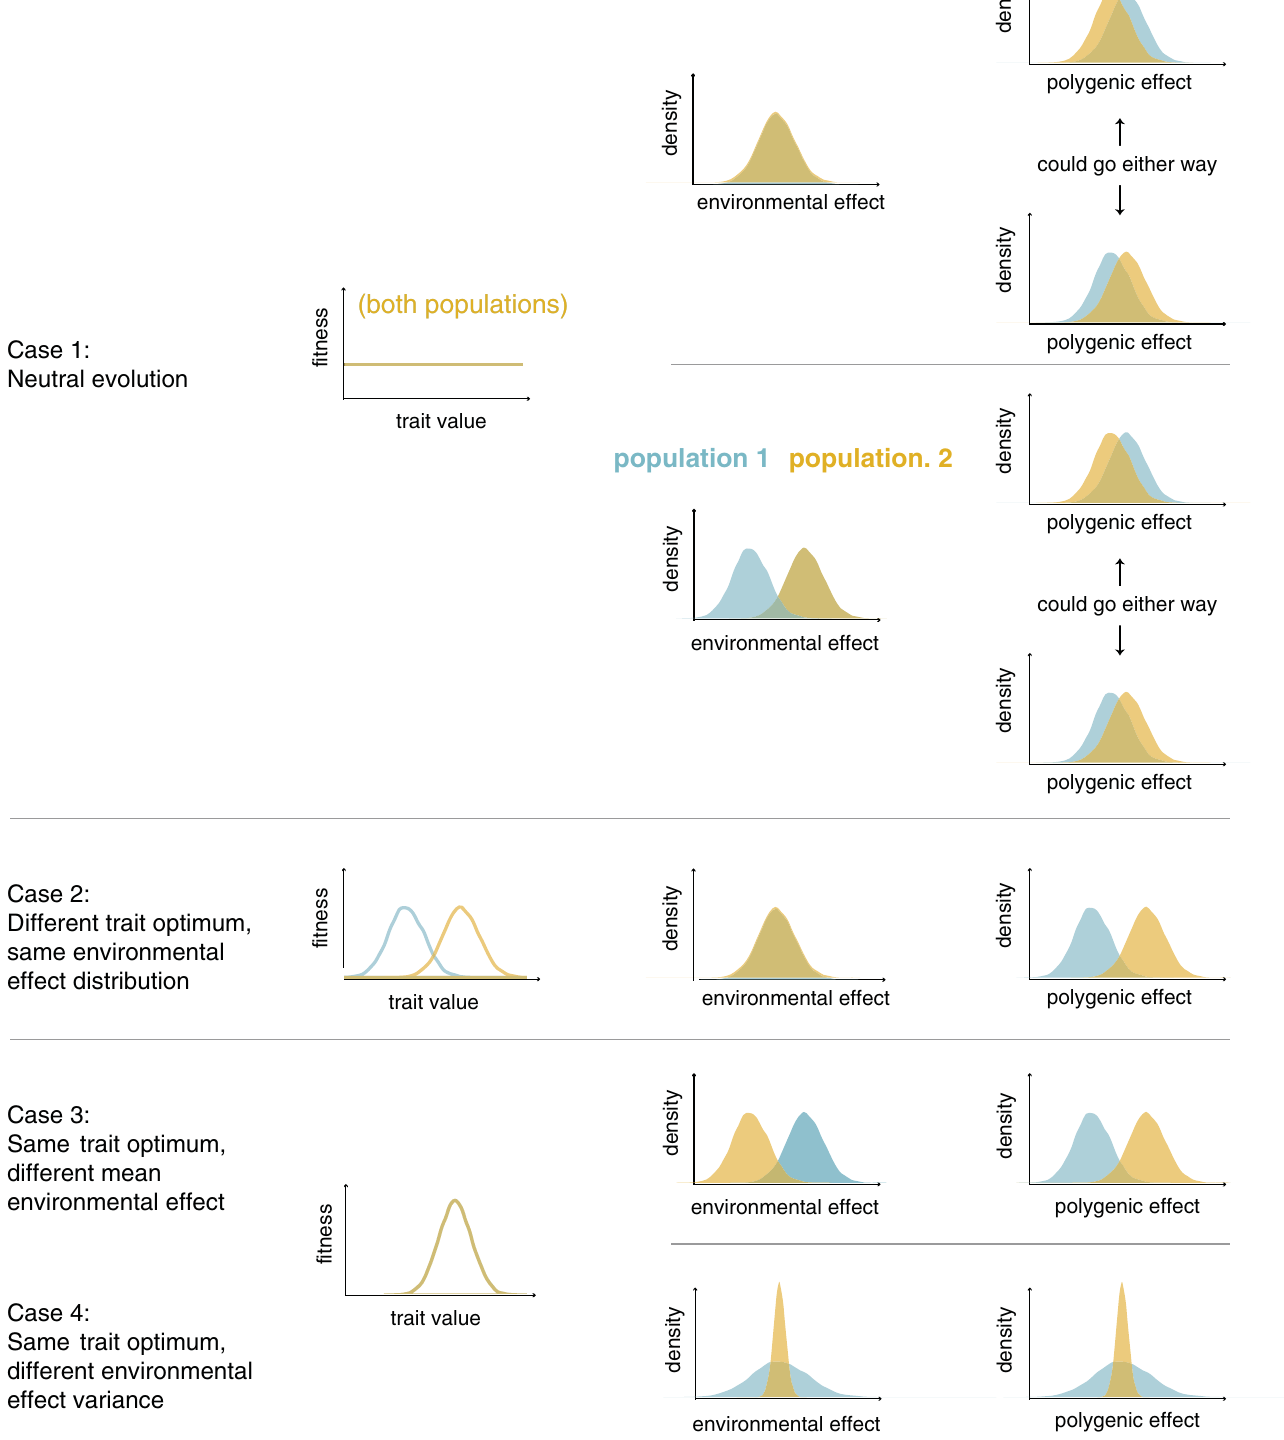
Fig 1. The mean polygenic effect is expected to differ between populations under plausible selection regimes and environmental effects on a trait.